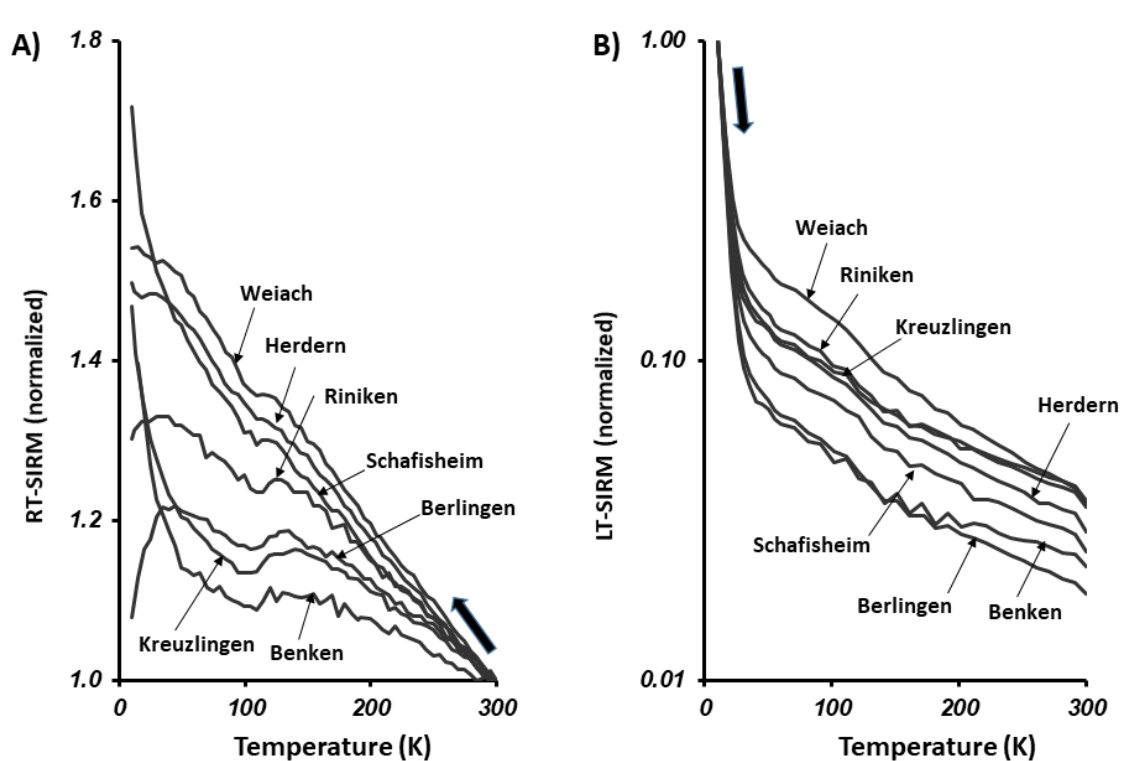
Figure 12. Magnetic results for Opalinus Clay. Cooling ( A ) and warming ( B ) of artificial remanence imparted at room temperature (RT-SIRM) and 10 K (LT-SIRM). The values of RT-SIRM and LT-SIRM were normalized. See Table 2 for the magnitude of the remanence.